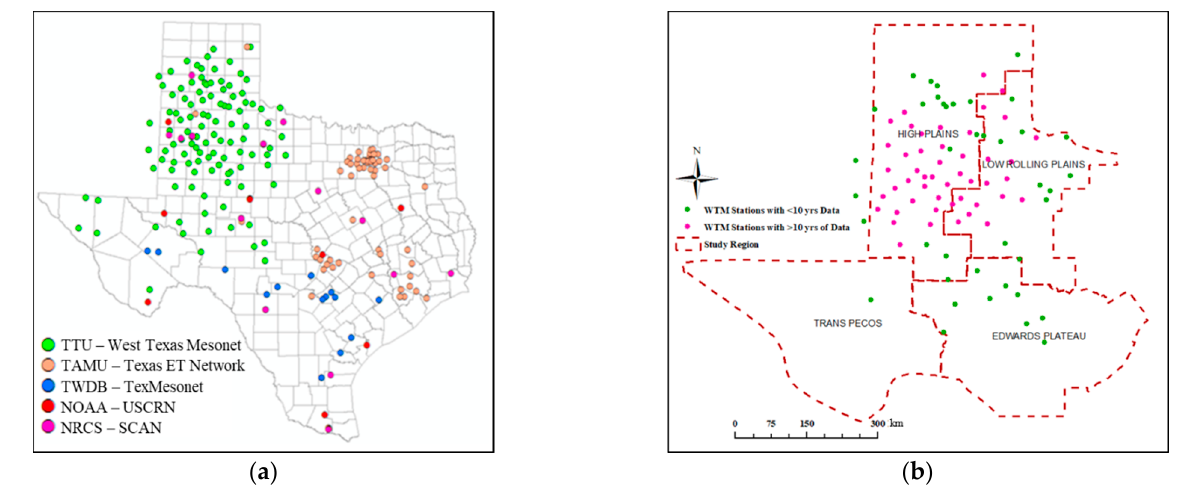
Figure 2. ( a ) Active weather station network across Texas; ( b ) locations of 48 WTM weather stations used in the analysis.